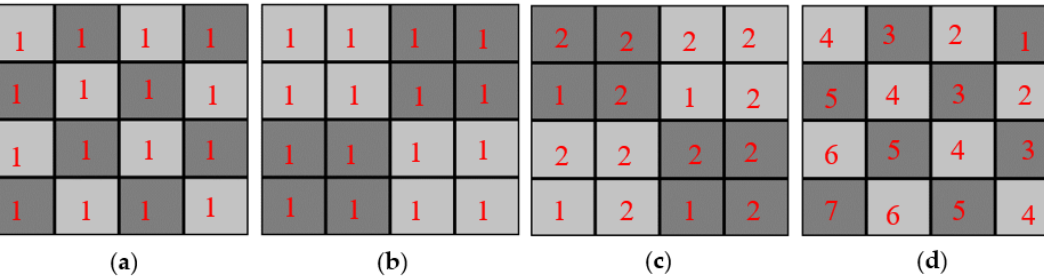
Figure 15. A 4 pixel × 4 pixel array can produce a range of di ff erent counts depending on its segmentation. The numbers in pixels refer to the order in which they are triggered. Pixels with the same number can be triggered in any order, so long as they are all triggered before higher numbered pixels. For the case where no CSCA is applied ( a ) the maximum count rate is equal to the number of pixels, 16. For a static 2 × 2 CSCA ( b ) the maximum count rate is equal to the number of neighbourhoods defined, 4. For a dynamic 2 × 2 CSCA however the maximum count rate depends on the order in which the pixels are triggered and can range from 4 ( c ) up to 16 ( d ). The more highly